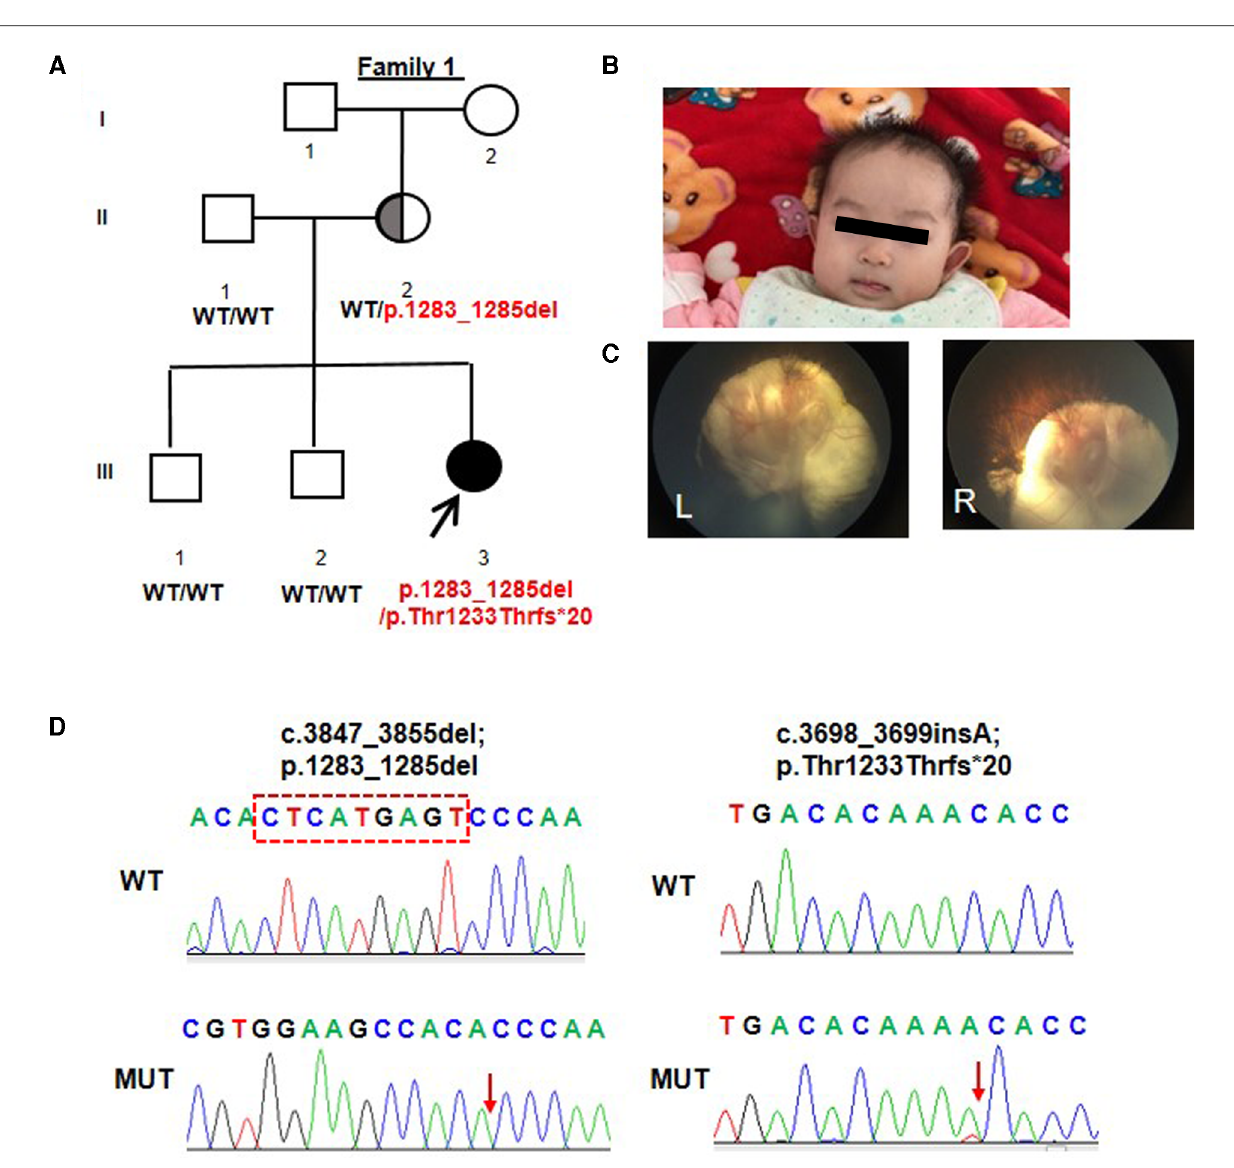
FIGURE 1 Trio-based WES identi fi ed compound heterozygous variants (p.Leu1283_Ser1285del; p.Thr1233Thrfs*20) in TENM3 in a patient with bilateral microphthalmia, global developmental delay, and microcephaly. ( A ) Pedigree and genotype information for members of family 1. Squares indicate males, circles indicate females, fi lled symbols indicate affected individuals, and open symbols indicate healthy individuals. Patient 1 is denoted by a black arrow. The proband carried compound heterozygous variants: c.3847_3855del; p.Leu1283_Ser1285del and c.3698_3699insA; p.Thr1233Thrfs*20. The mother (II-2) with heterozygosity of the p.Thr1233Thrfs*20 variant had left exophthalmia and graduated from middle school with poor grades. ( B ) Facial picture of the proband at the age of 5 months with microphthalmia, prominent and low-set ears, and microcephaly. ( C ) Fundus examination of patient 1 revealed the posterior pole of the retina colobomas involving the optic discs and the fovea. ( D ) A TA clone sequencing from the genomic DNA of patient 1 including the fragment of exon 19 showed the two variants: c.3847_3855del; p.Leu1283_Ser1285del and c.3698_3699insA; p.Thr1233Thrfs*20. WT, wild type; MUT, mutant